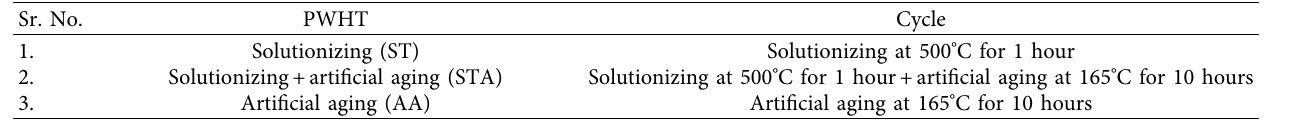
Table 3: Postweld heat treatment cycles used in this investigation. Sr.